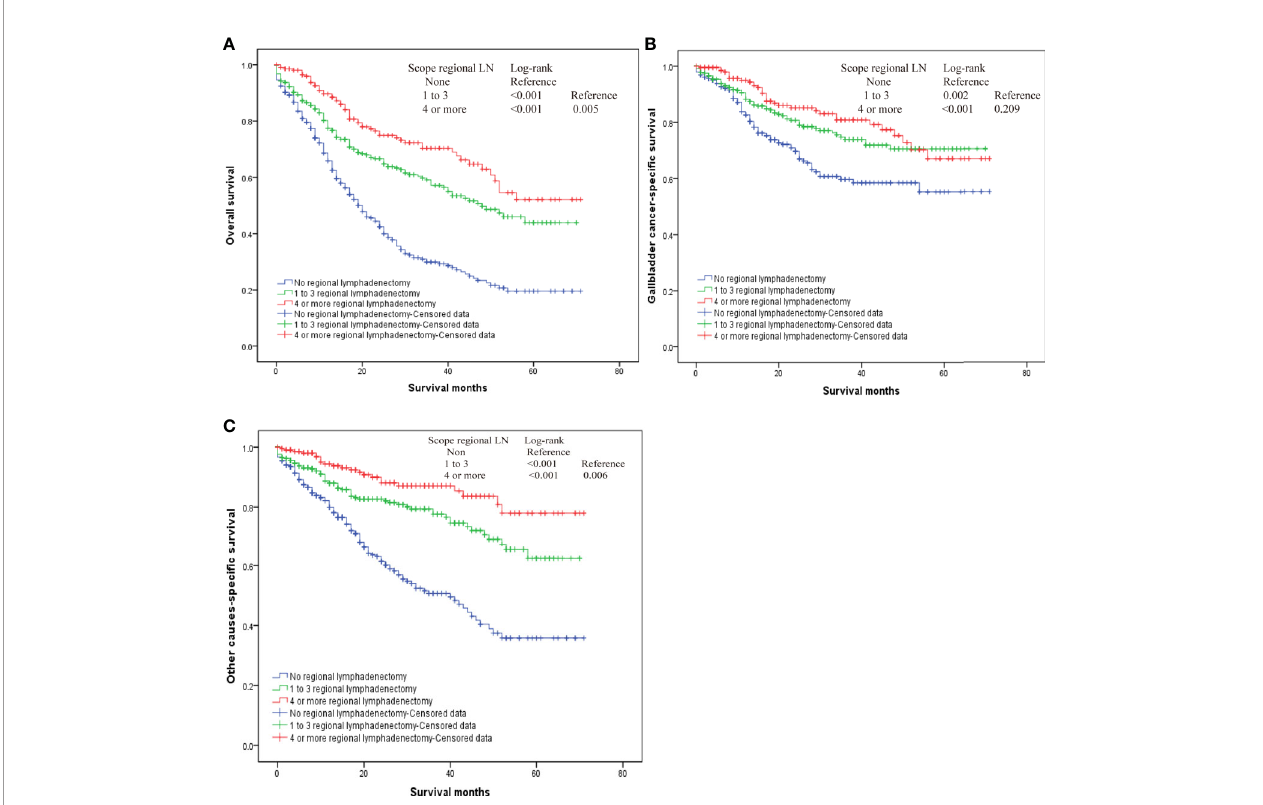
FIGURE 3 | The overall survival for T2 gallbladder cancer who underwent regional lymphadenectomy. (A) Kaplan – Meier plots for overall survival. (B) Kaplan – Meier plots for cumulative gallbladder cancer-speci fi c survival. (C) Kaplan – Meier plots for cumulative other cause-speci fi c